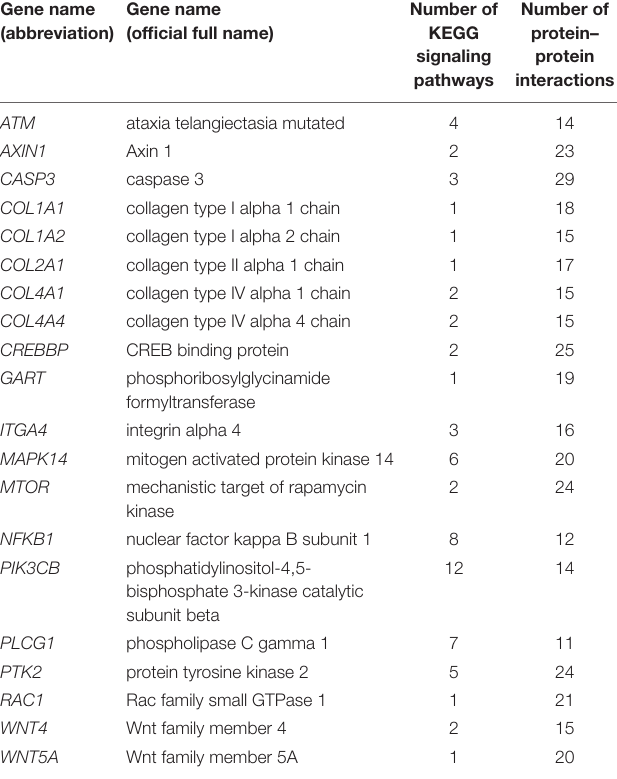
TABLE 5 | Summary of 20 key